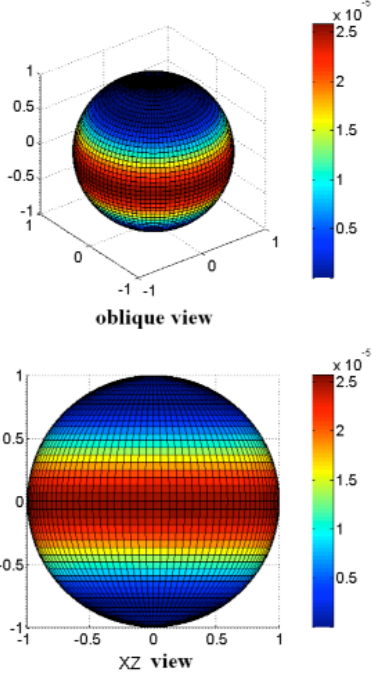
Figure 12. The distribution of on the sphere surface.